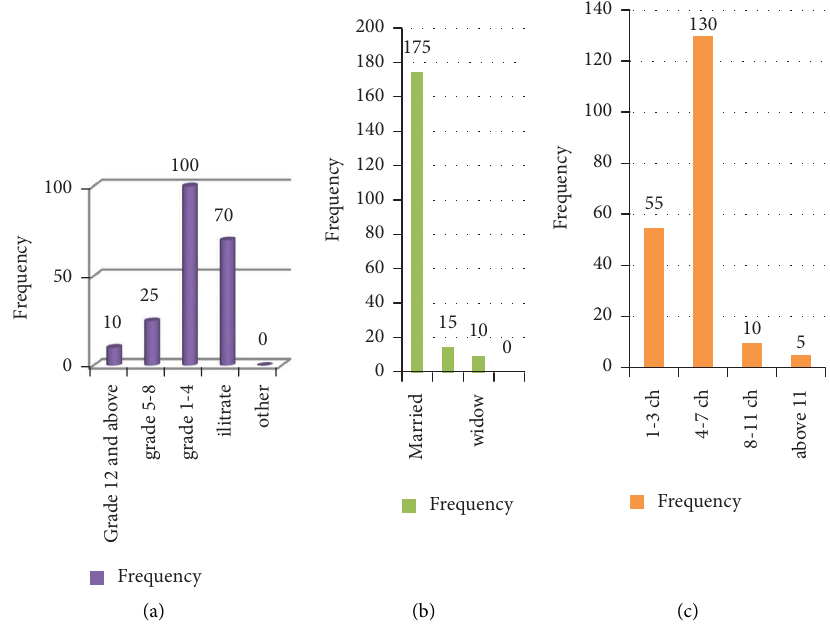
Figure 3: Te diagrams showing the (a) education level, (b) marital status, and (c) household family size. Table 2: Average laboratory results of temperature, turbidity, and temperature of the topsoil (0.20 cm) of the wetland plots. Parameter Plot 1 Plot 2 Plot 3 Plot 4 Plot 5 Plot 6 Temperature ( ° c) 14.73 14.43 14.93 14.13 14.6 14.7 Turbidity Moisture